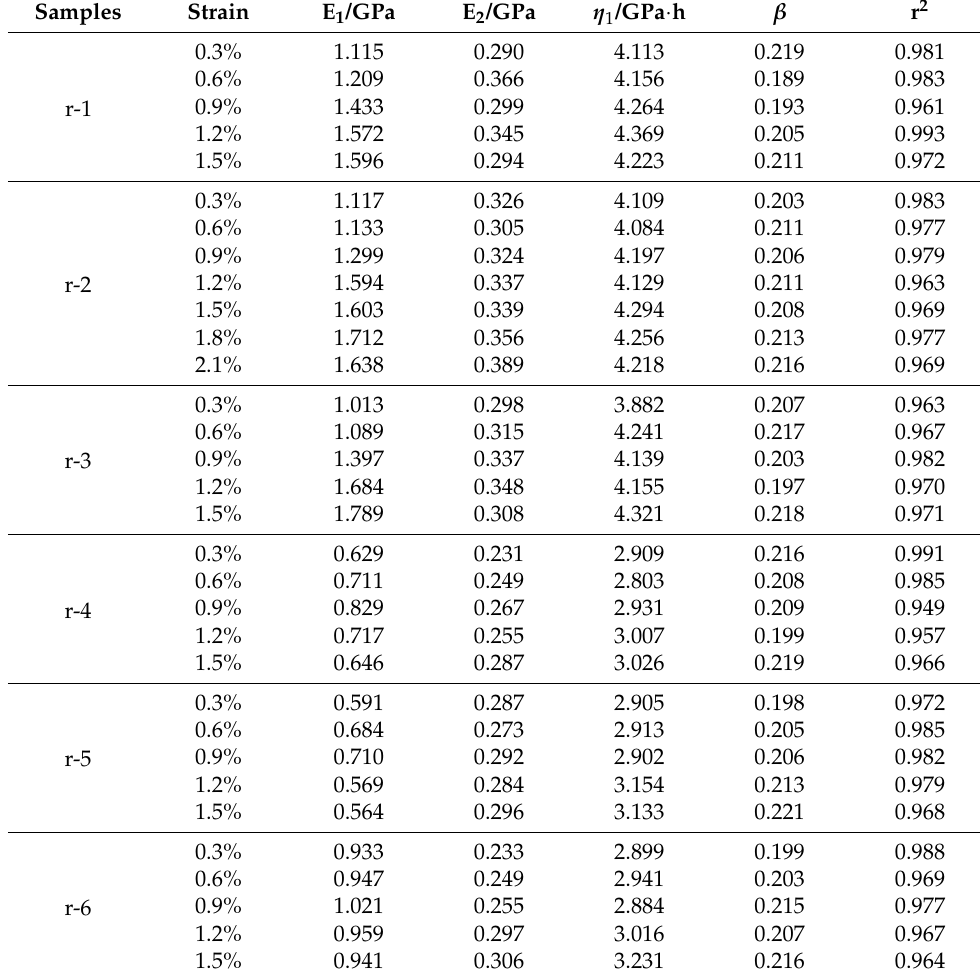
Table 4. The parameters identified in the stress relaxation in the core damage